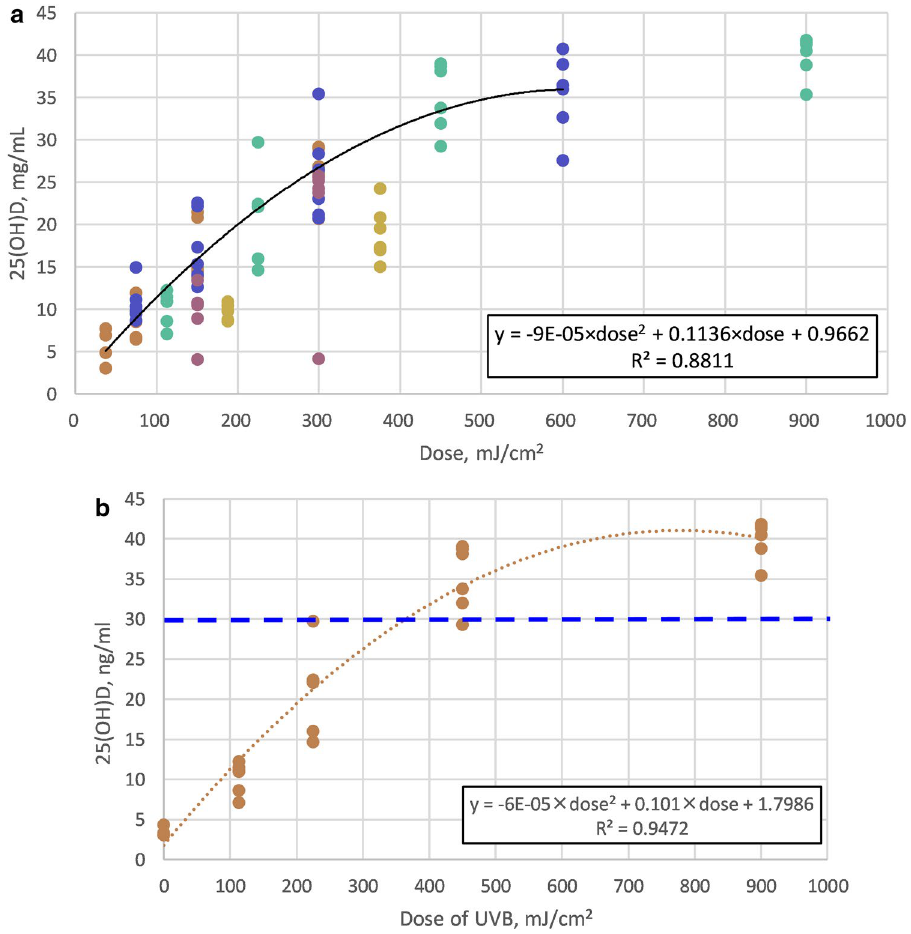
Figure 2. The distibution of 25(OH)D level and relationship with cumulative dosage of UVB irradiation. ( a ) For all time-point irradiation; ( b ) at 3 w irradiation. The optimal mathematical function to describe the associations between UBV irradiation dosages and 25(OH)D level at 3 w was determined by maximal R square value. The optimal dosage of UVB (355 mj/cm 2 ) to reach 25(OH)D level at 30 ng/mL was estimated based on the mathematical